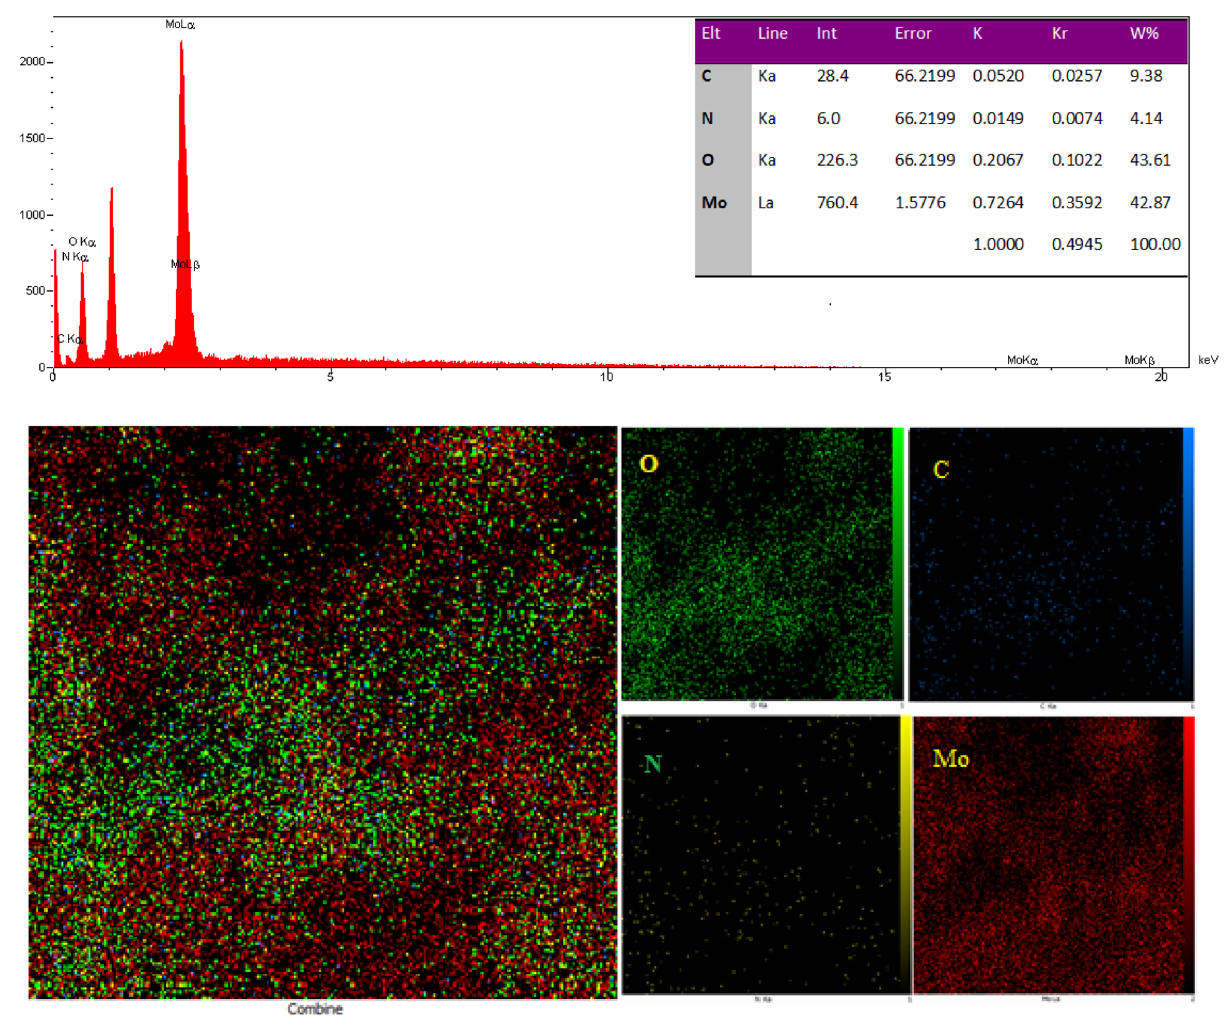
Figure 4. X-ray mapping analysis and EDX spectra for